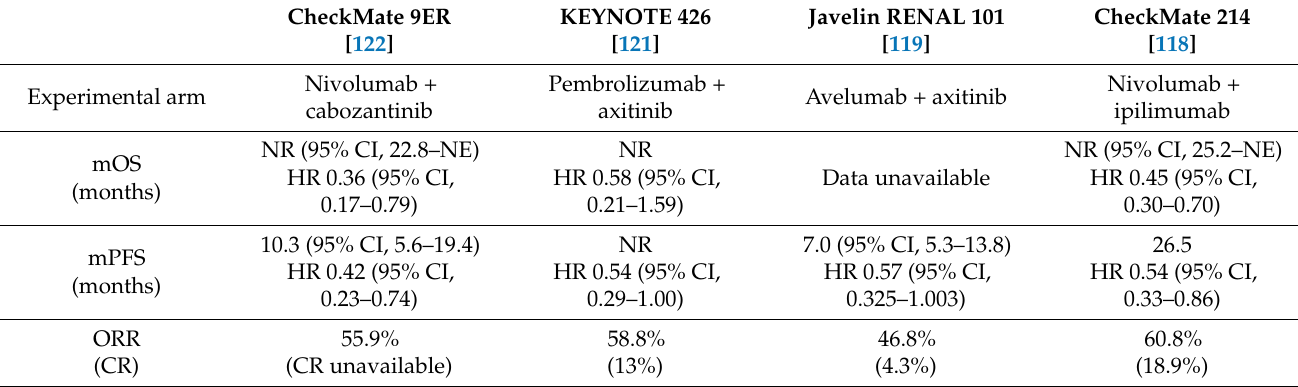
Table 4. Survival outcomes and antitumor activity of ICI-based regimens among RCC with sarcomatoid